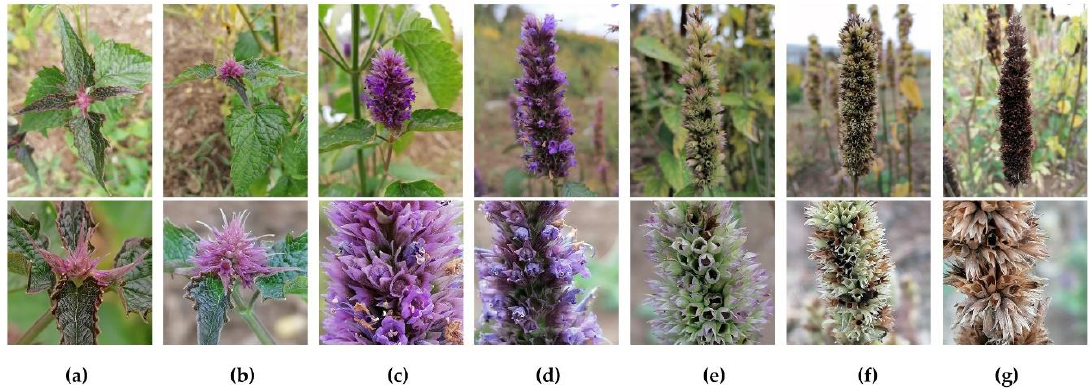
Figure 4. Reproductive growth stages of the Agastache species studied according to the BBCH scale: ( a ) stage 50; ( b ) stage 55; ( c ) stage 61; ( d ) stage 65; ( e ) stage 69; ( f ) stage 79; ( g ) stage 89; images from the second row are details (original).